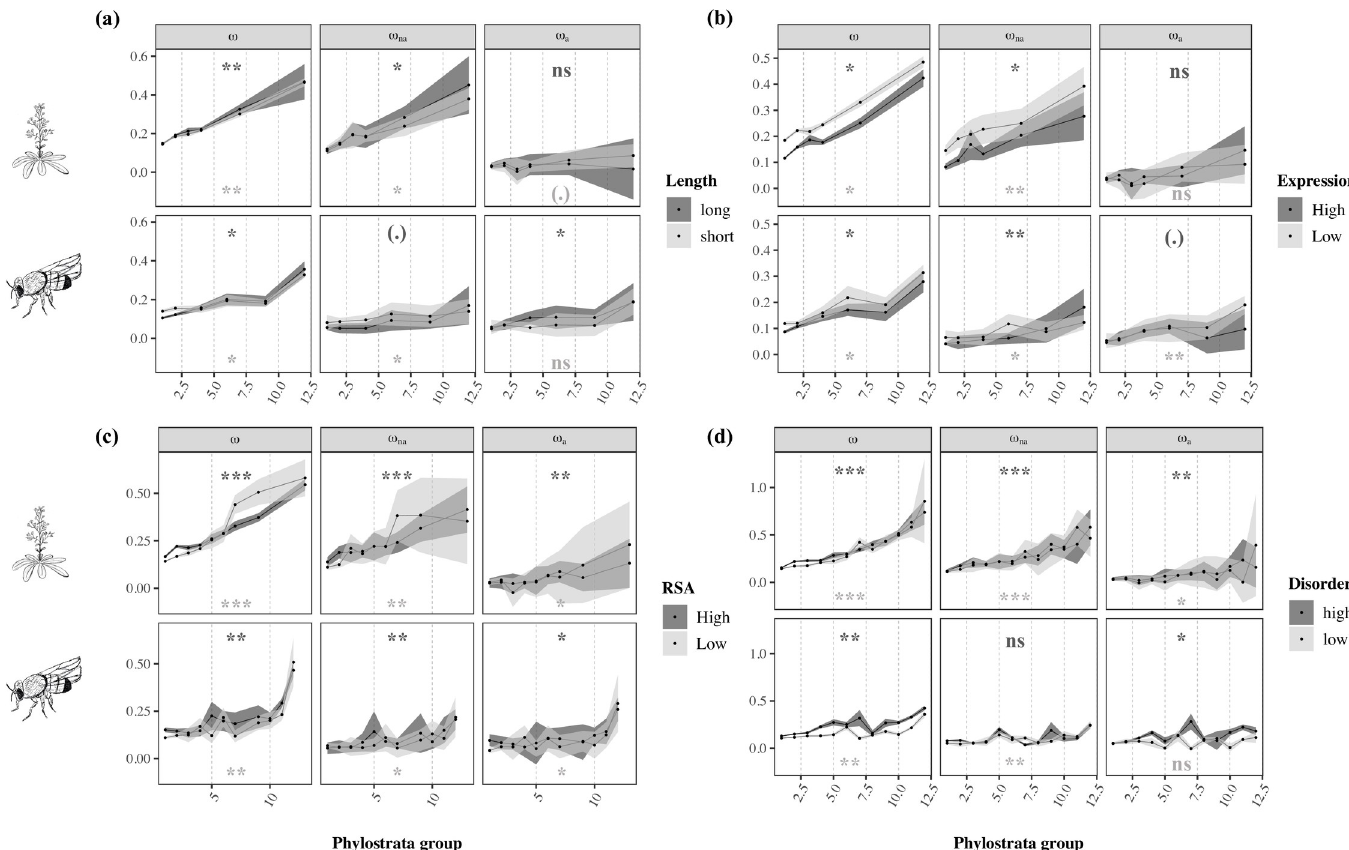
Fig 2. Estimates of ω , ω na , and ω a plotted as a function of (a) protein length and (b) mean expression levels, (c) RSA, and (d) protein intrinsic disorder with gene age in A . thaliana (top) and D . melanogaster (bottom). Analyses were performed by comparing short and long genes (a) , lowly and highly expressed genes (b) , proteins with low and high mean RSA values (c) , and proteins with low and high average intrinsic disorder (d) across age categories (see Material and methods). Legend as in Fig 1. Significance levels are shown for each correlation between gene age and the rates of protein evolution ( � P < 0.05; �� P < 0.01; ��� P < 0.001; “.” 0.05 � P < 0.10; “ns” P > 0.10). The data (S6–S9 Data tables) and code needed to generate this table can be found at https://gitlab.gwdg.de/molsysevol/supplementarydata_geneage and https://